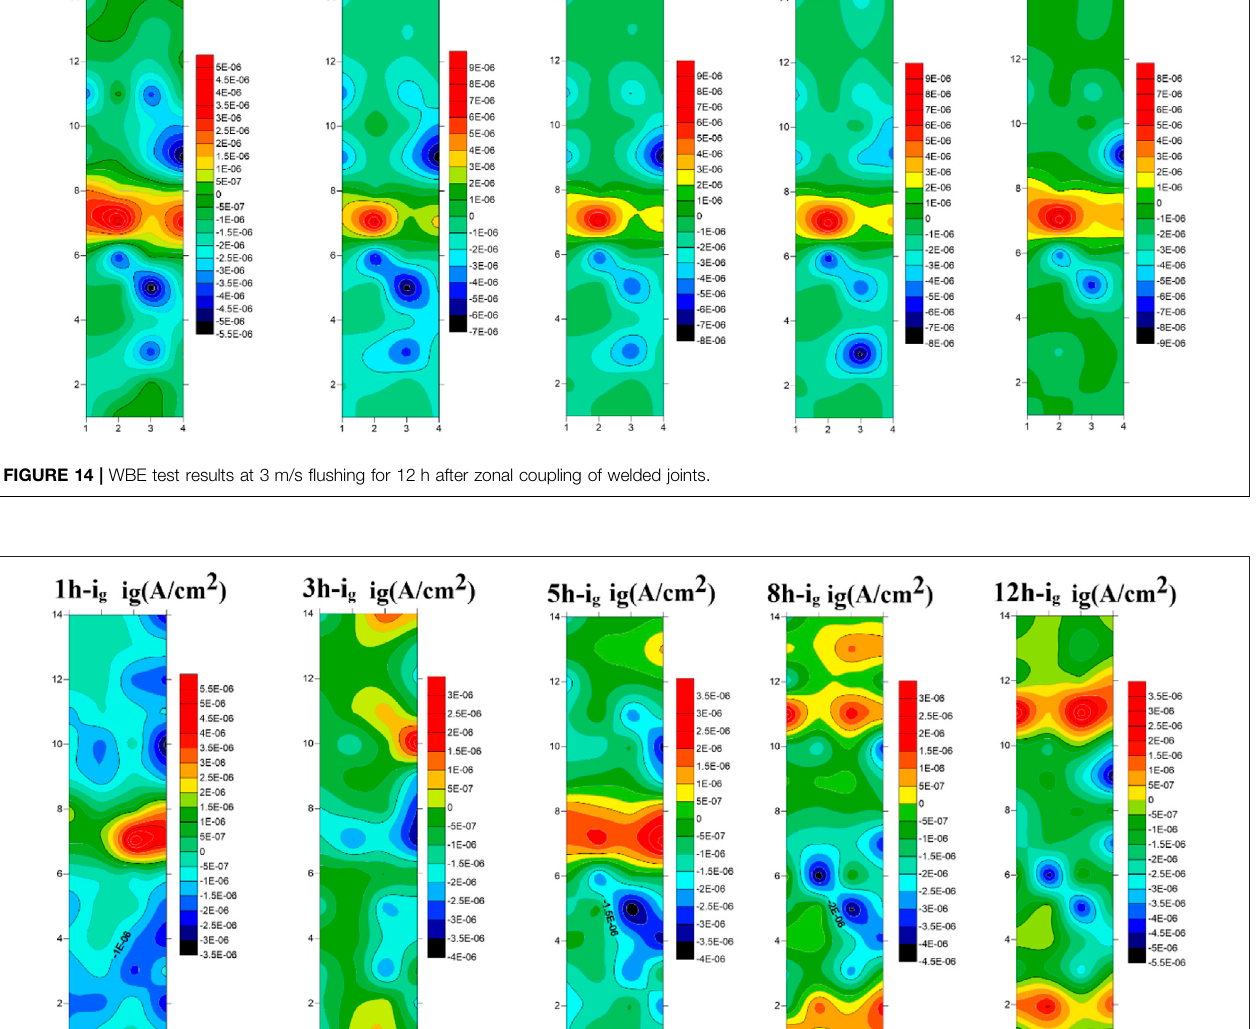
Frontiers in Materials |